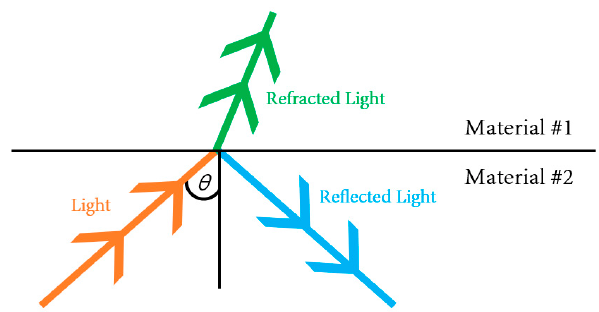
Figure 12. Reflection concept of the TIR principle.